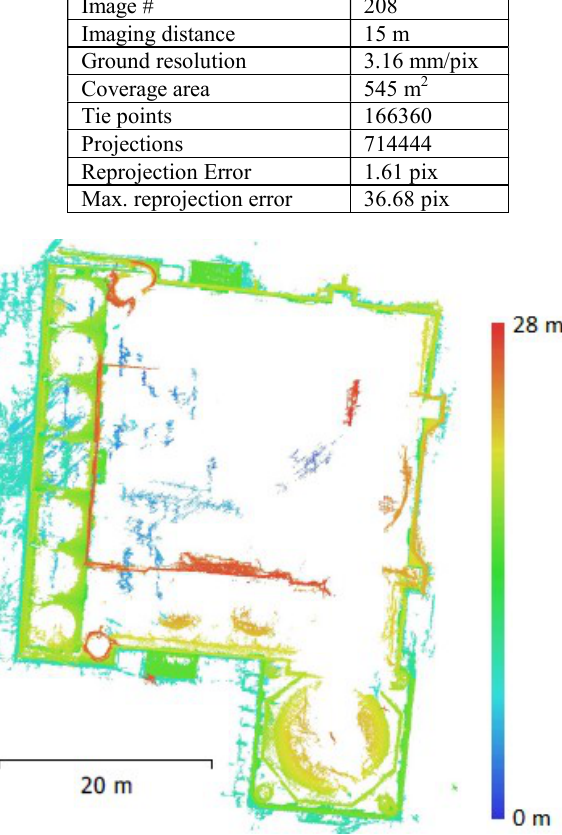
Figure 9. Digital elevation model (Top